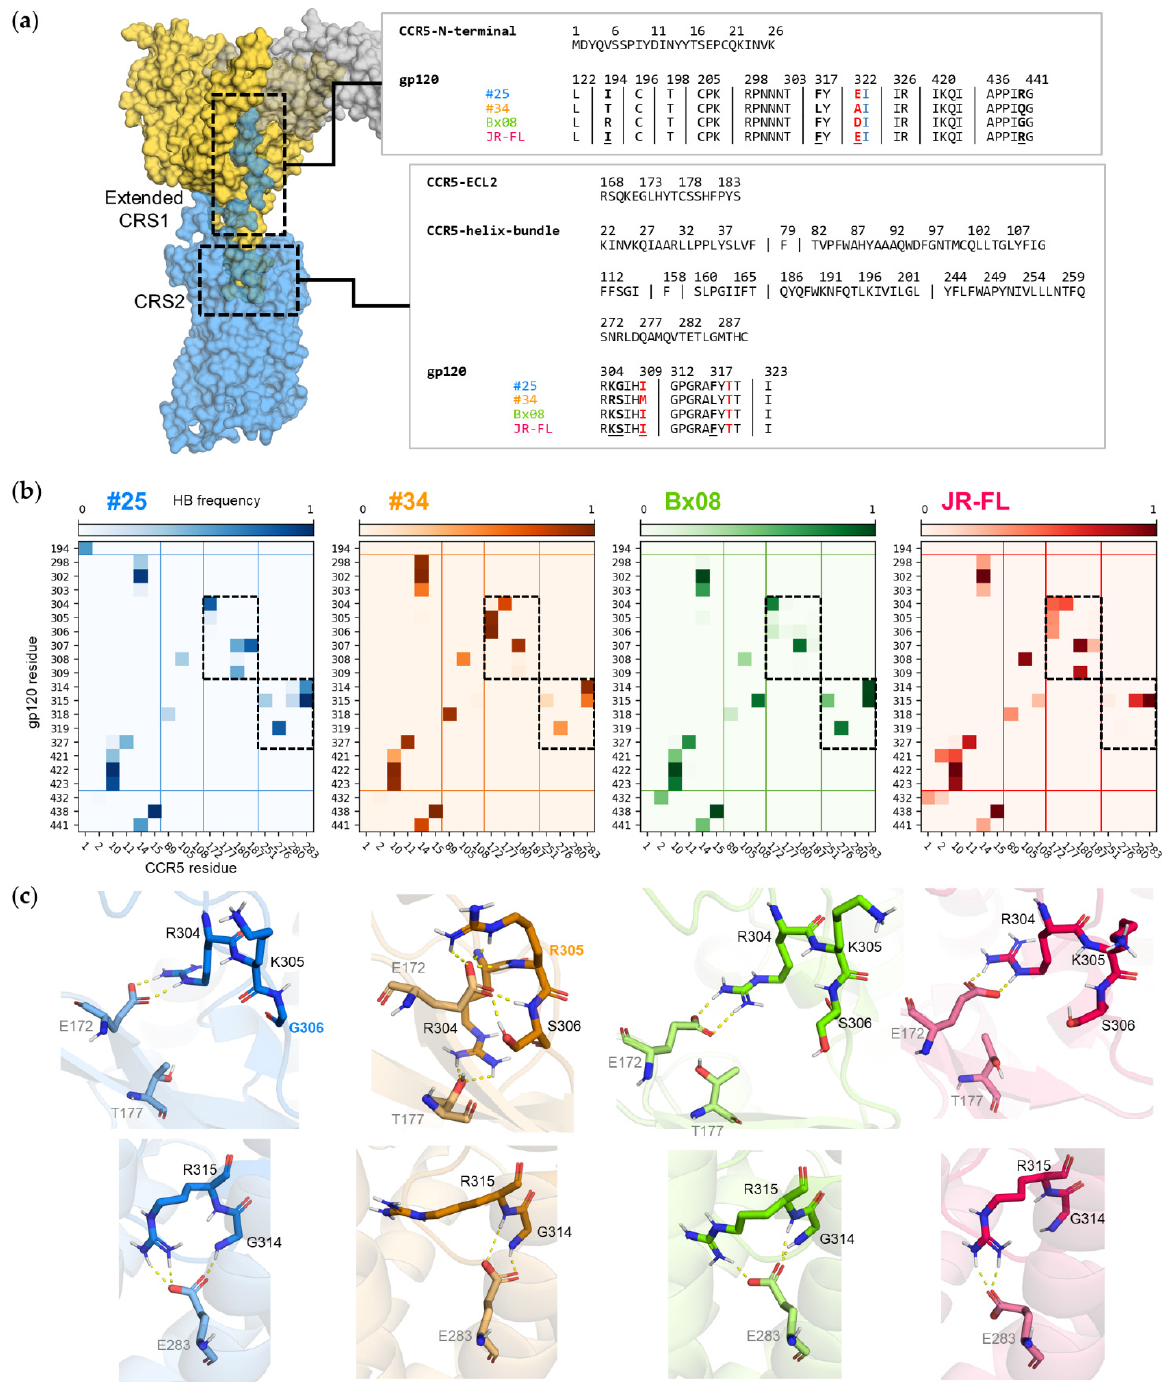
Figure 5. CCR5/gp120 interfaces in CD4–gp120–CD4 complexes: ( a ) amino acid sequences. Gp120 residues in red form interaction with CCR5 in the simulated structure but not in the cryo-EM structure (PDB ID: 6MEO). Gp120 residue Ile322A, in blue, is an insertion as compared with HxB2 reference sequence. Underlined positions are non-conserved residues; ( b ) frequency of the hydrogen bonds formed between gp120 and CCR5 in simulated structures. Frequency ranges from 0 (light color) to 1 (dark color). Lines delineate protein domains (gp120: bridging sheet, V3, V2; CCR5: N-terminal domain, helix 2–3 minor subpocket; ECL2 and top of helix 5; helix 6–7 major subpocket) and boxes focus on contacts shown on panel ( c ); ( c ) key interactions between gp120 V3 and CCR5 TM (top) and ECL2 (bottom). CCR5 is shown as ribbon, residues in interaction as sticks; ( b , c ) data points and protein structures of CD4–gp120 #25 –CCR5, CD4–gp120 #34 –CCR5, CD4–gp120 Bx08 –CCR5 and CD4–gp120 JR-FL –CCR5 are colored in blue, orange, green and red, respectively. In ( c ), labels of gp120-specific amino acids are colored according to the same scheme.